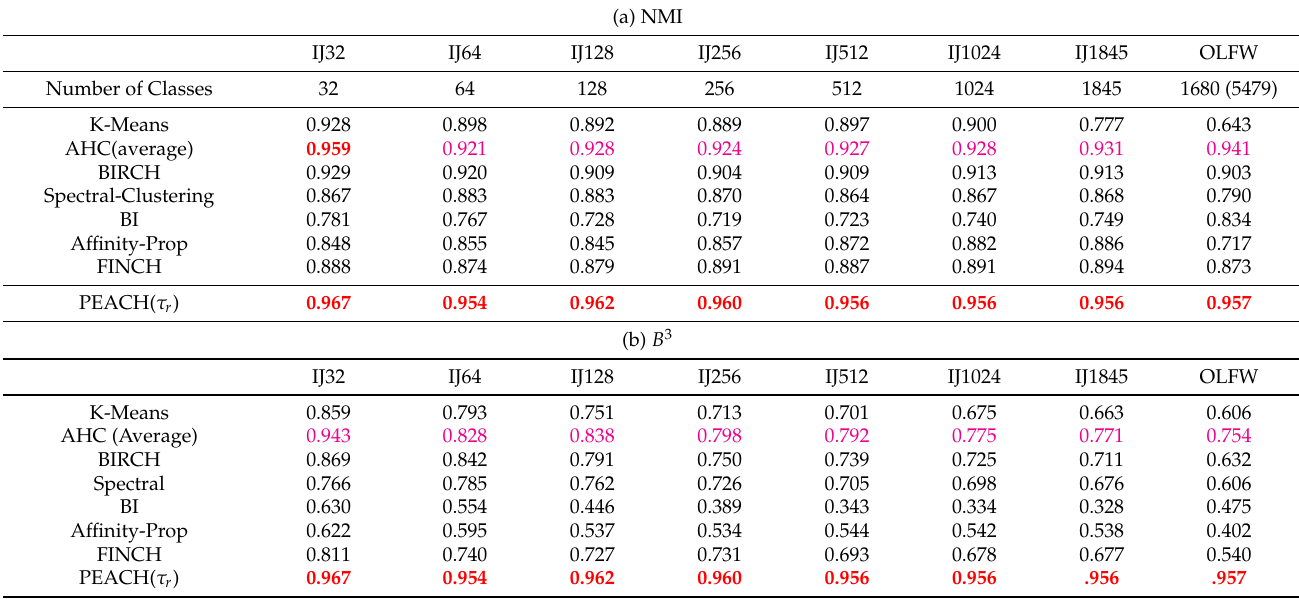
Table 8. Utilizing Ground-Truth Number of Classes. These tables include NMI and B 3 results for various classic algorithms when using the ground number of classes in the face clustering experiments. We mark the second-best and best results .